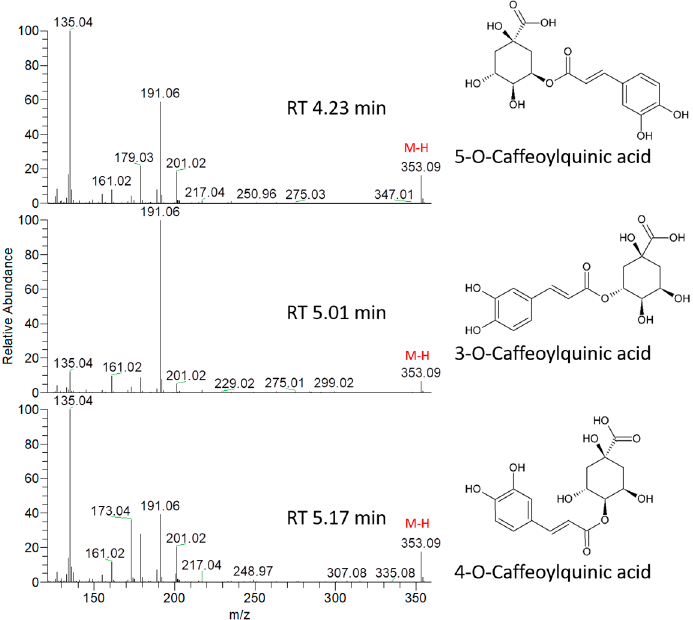
Figure 2. MS/MS spectrum of the [M − H] − ions for the peaks at 4.23, 5.01 and 5.17 min representing caffeoylquinic acid isomers.